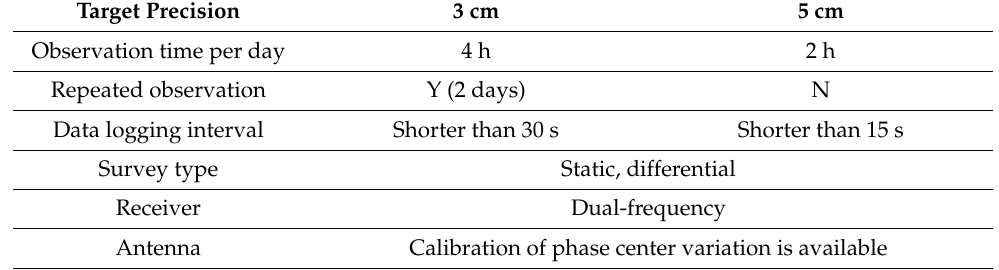
Table 1. Surveying conditions for GNSS-derived height determination in Korea [10]. Target Precision 3 cm 5 cm